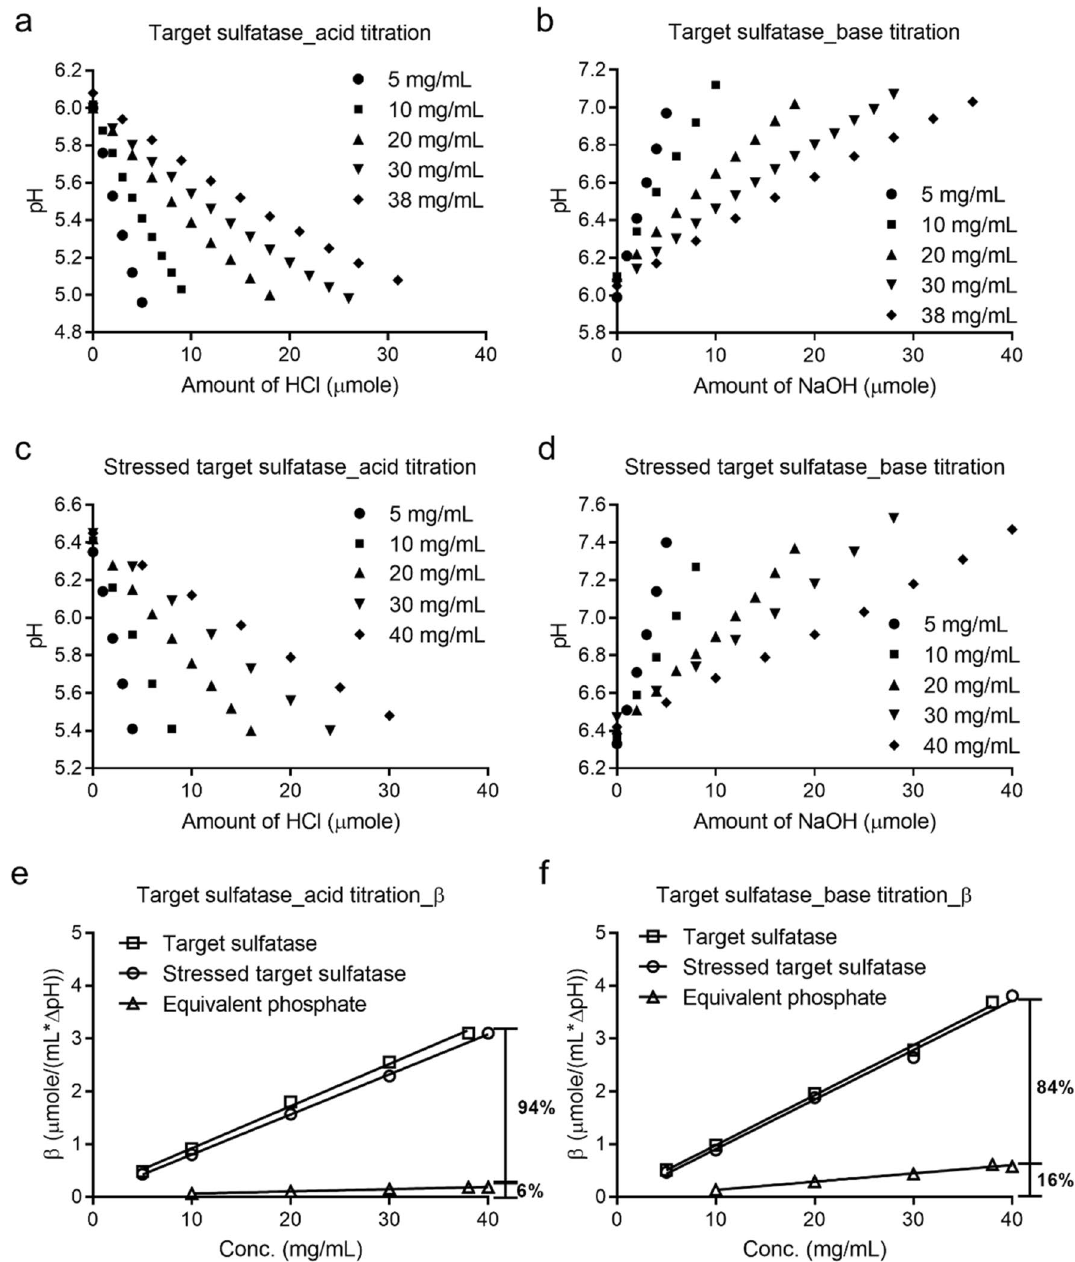
Figure 3. Acid or base titration curves and buffering capacity of target and stressed target sulfatases at different